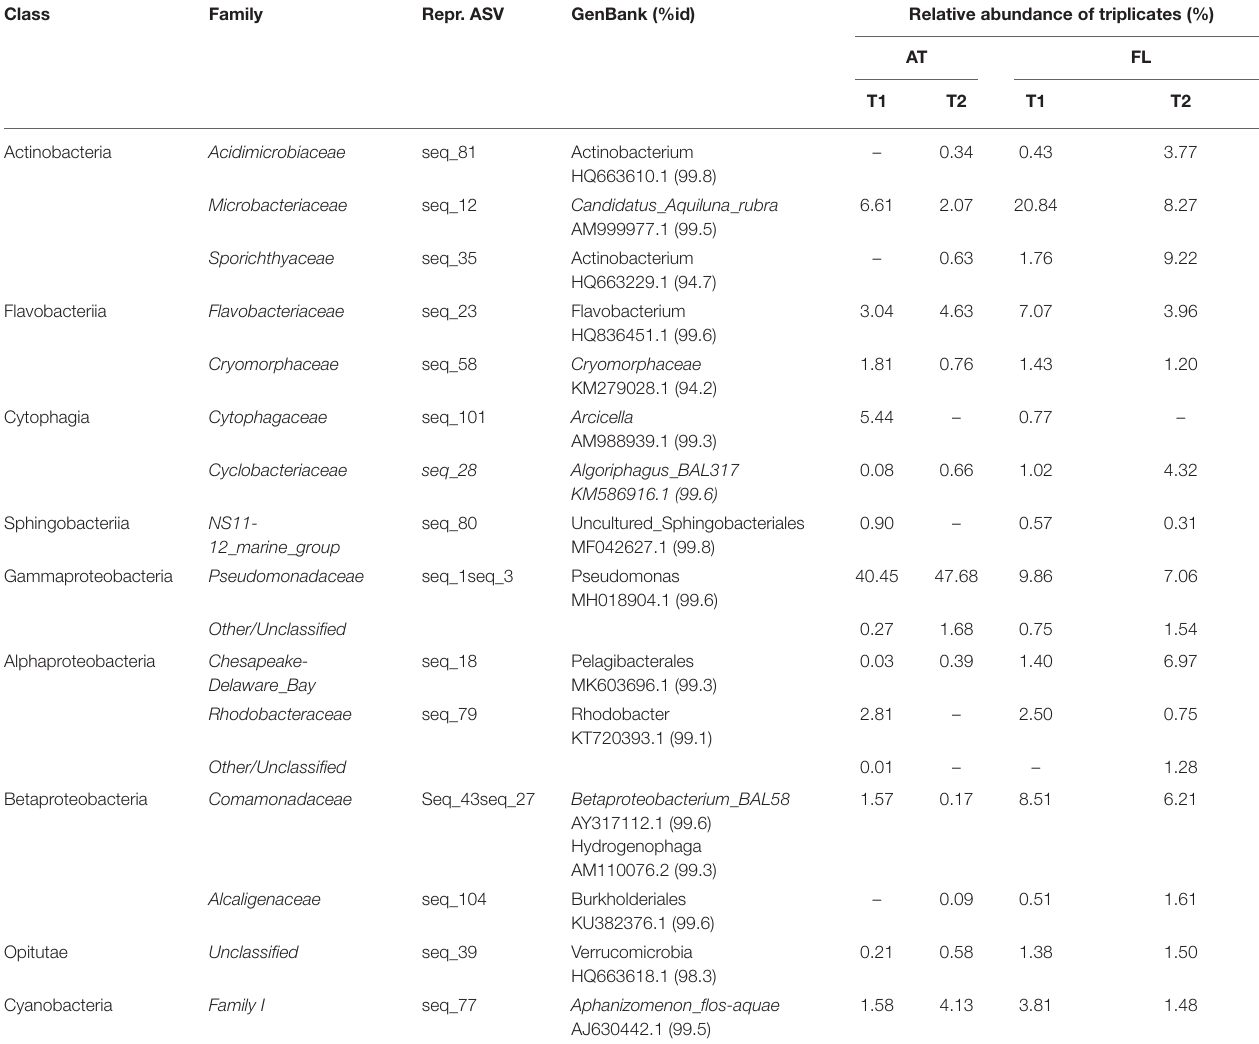
TABLE 3 | Taxons, at class and family level, of representative BAC ASVs (16S), with accession numbers for matches in GenBank with % identity.